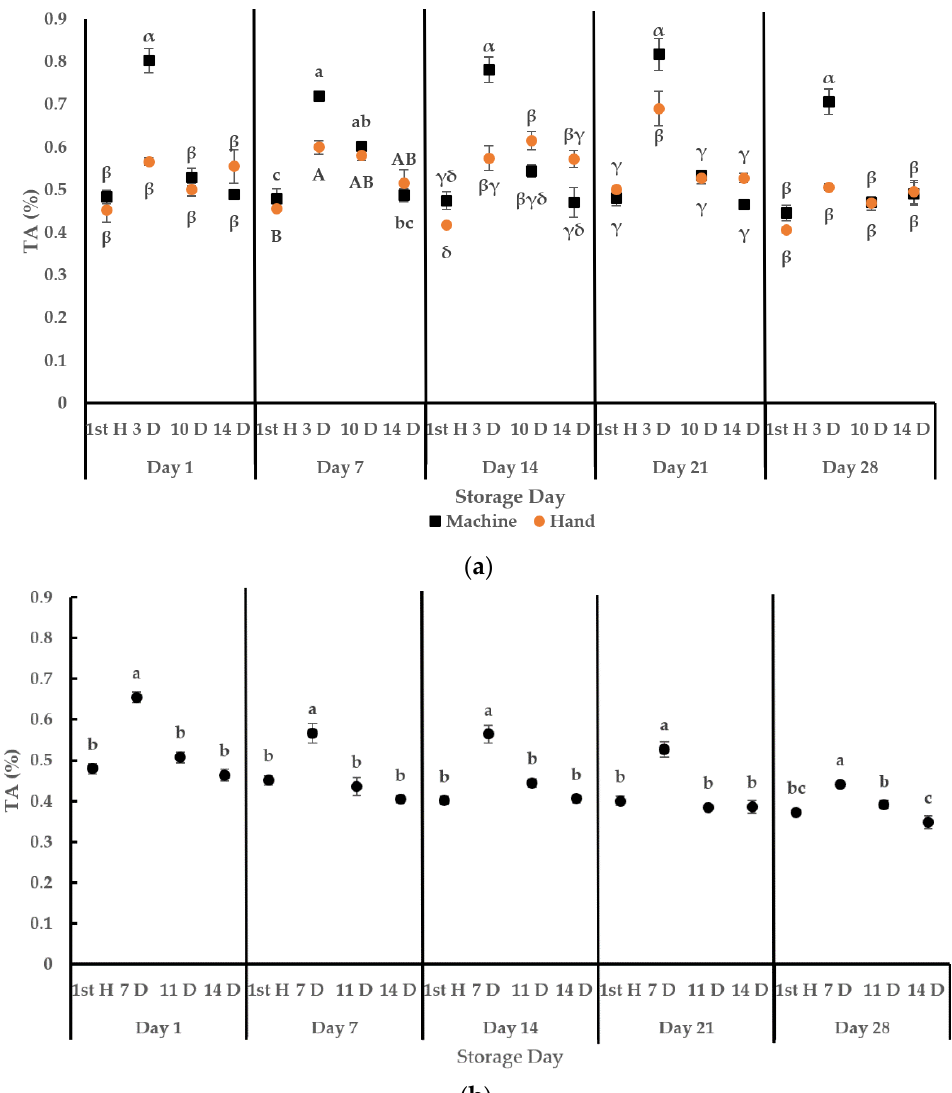
Figure 6. Titratable acidity (TA) of ‘Liberty’ northern highbush blueberry in 2019 ( a ) and 2020 ( b ) at 1, 7, 14, 21, and 28 days after packing. Fruits were harvested at 3-, 10-, and 14-day harvest intervals in 2019 and at 7-, 11-, and 14-day harvest intervals in 2020. The first harvest was the baseline from which interval treatments were established. Fruits were harvested by hand or using a modified over-the-row (OTR) harvester with patent-pending elastomeric polymers installed on catching surfaces in northwest Washington, WA, USA. Values are mean ± SE ( N = 6). Different lowercase letters indicate significant differences ( p < 0.05) due to interval on each evaluation day. Different uppercase letters indicate significant differences ( p < 0.05) within hand-harvested fruits on each evaluation day due to harvest interval effect. Different Greek letters indicate significant differences ( p < 0.05) among both hand- and machine-harvested fruit on each evaluation day due to interaction effects of harvest method and interval. Hand and machine harvesting data are combined due to lack of harvest method and interaction effects in 2020 ( b ).